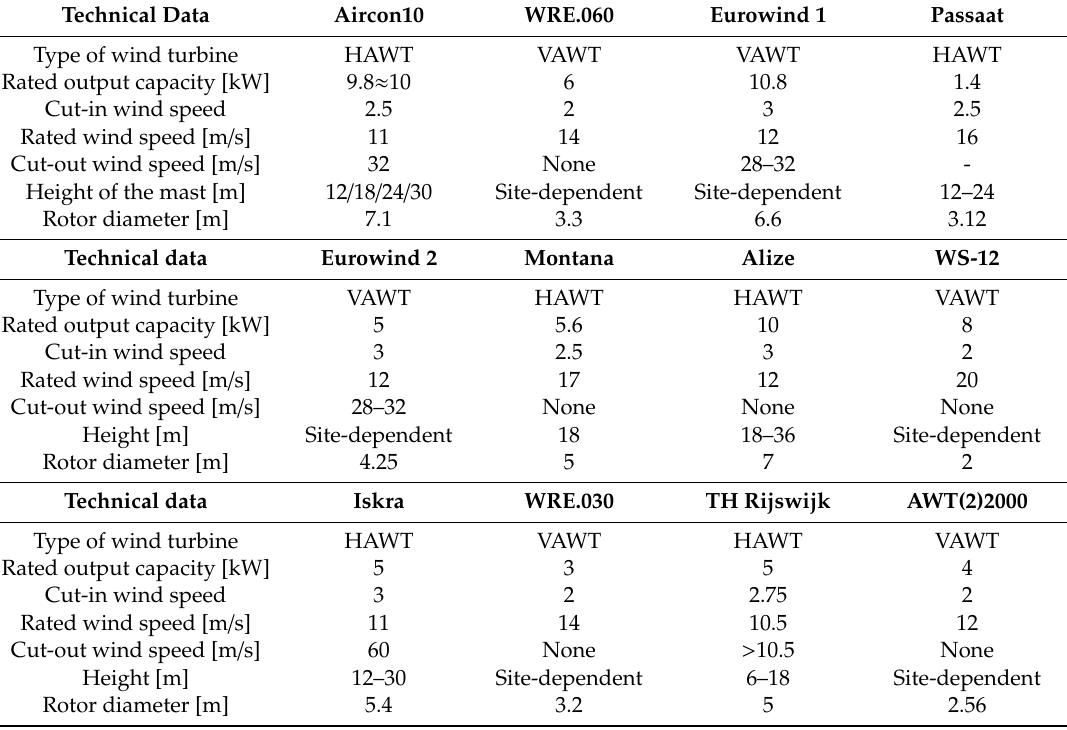
Table 7. Characteristics of the selected wind